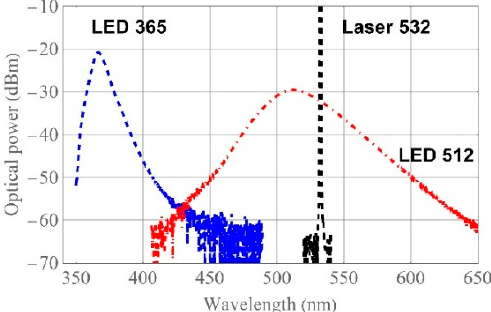
Figure 1. Spectral characteristics of light sources: UV LED, 365 nm (blue curve); VIS LED, 512 nm (red curve); and VIS laser 532 nm (black curve).